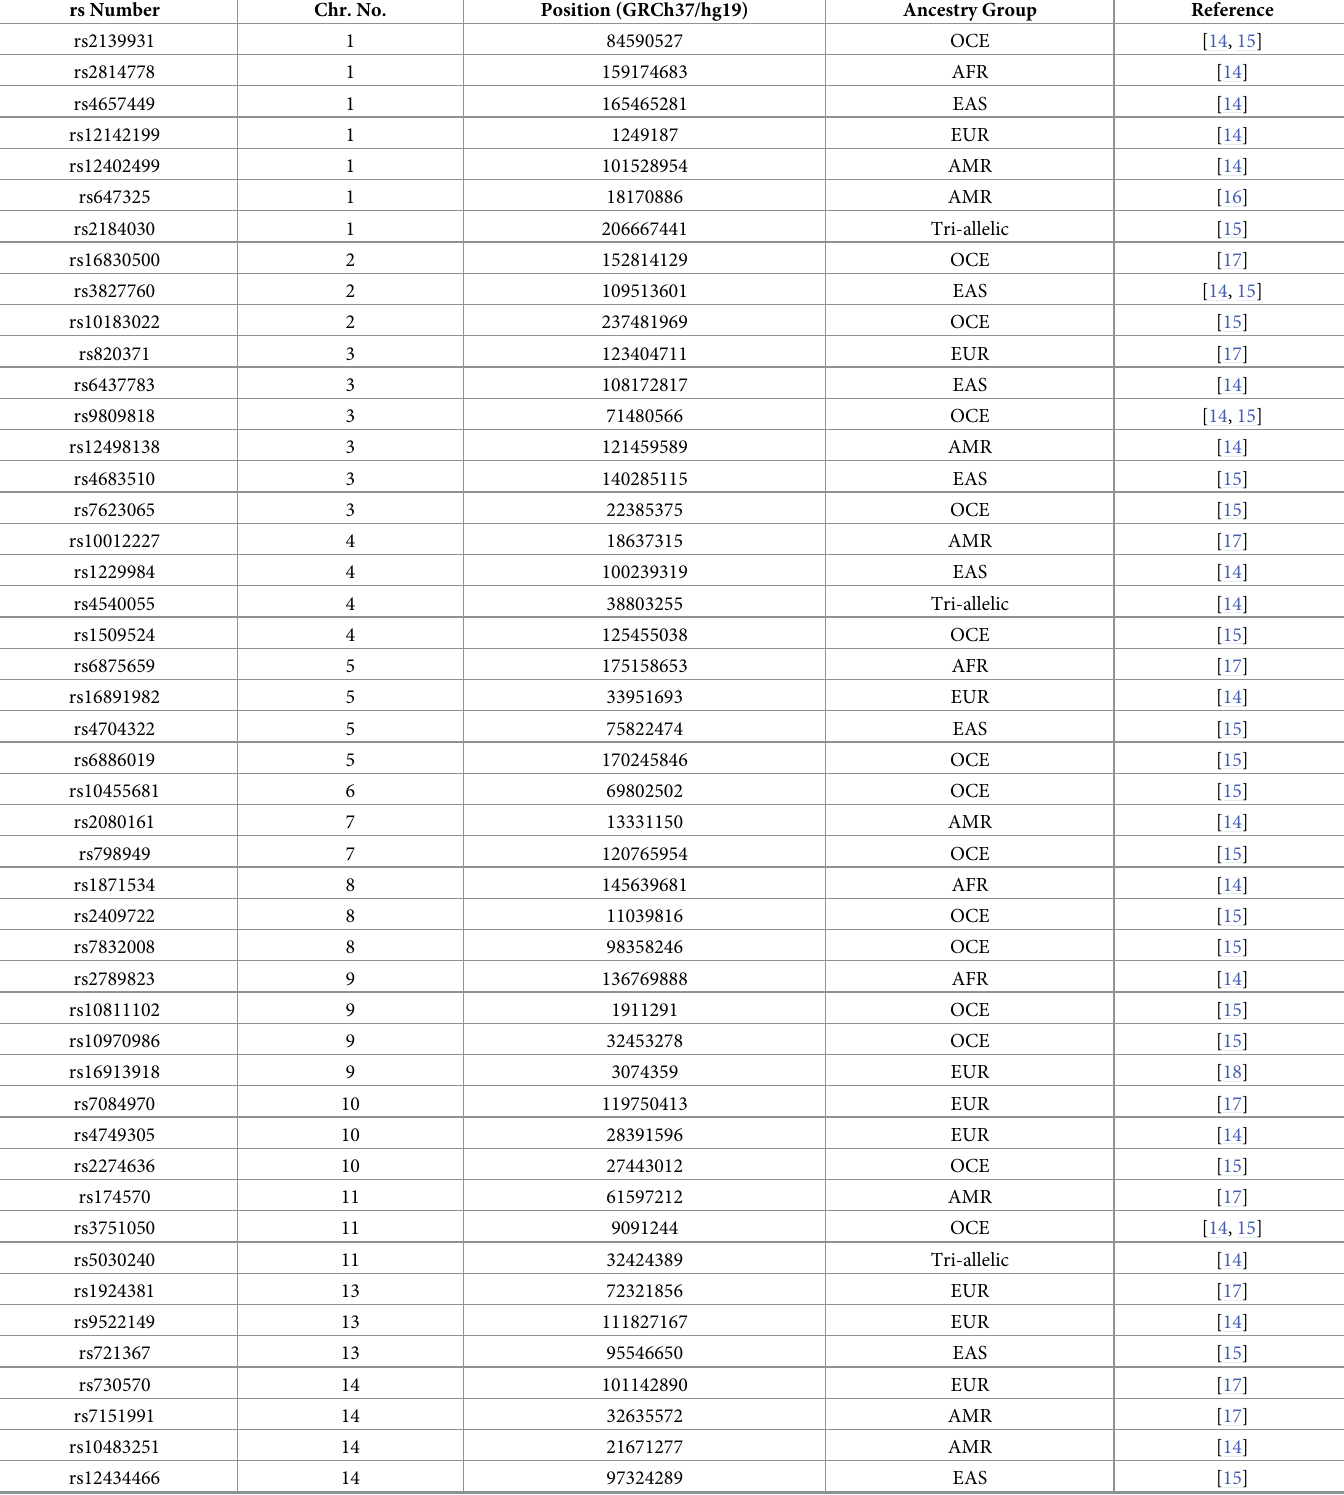
Table 1. Detailed information of the 67 biogeographic ancestry SNPs included in the hybridisation enrichment panel. rs